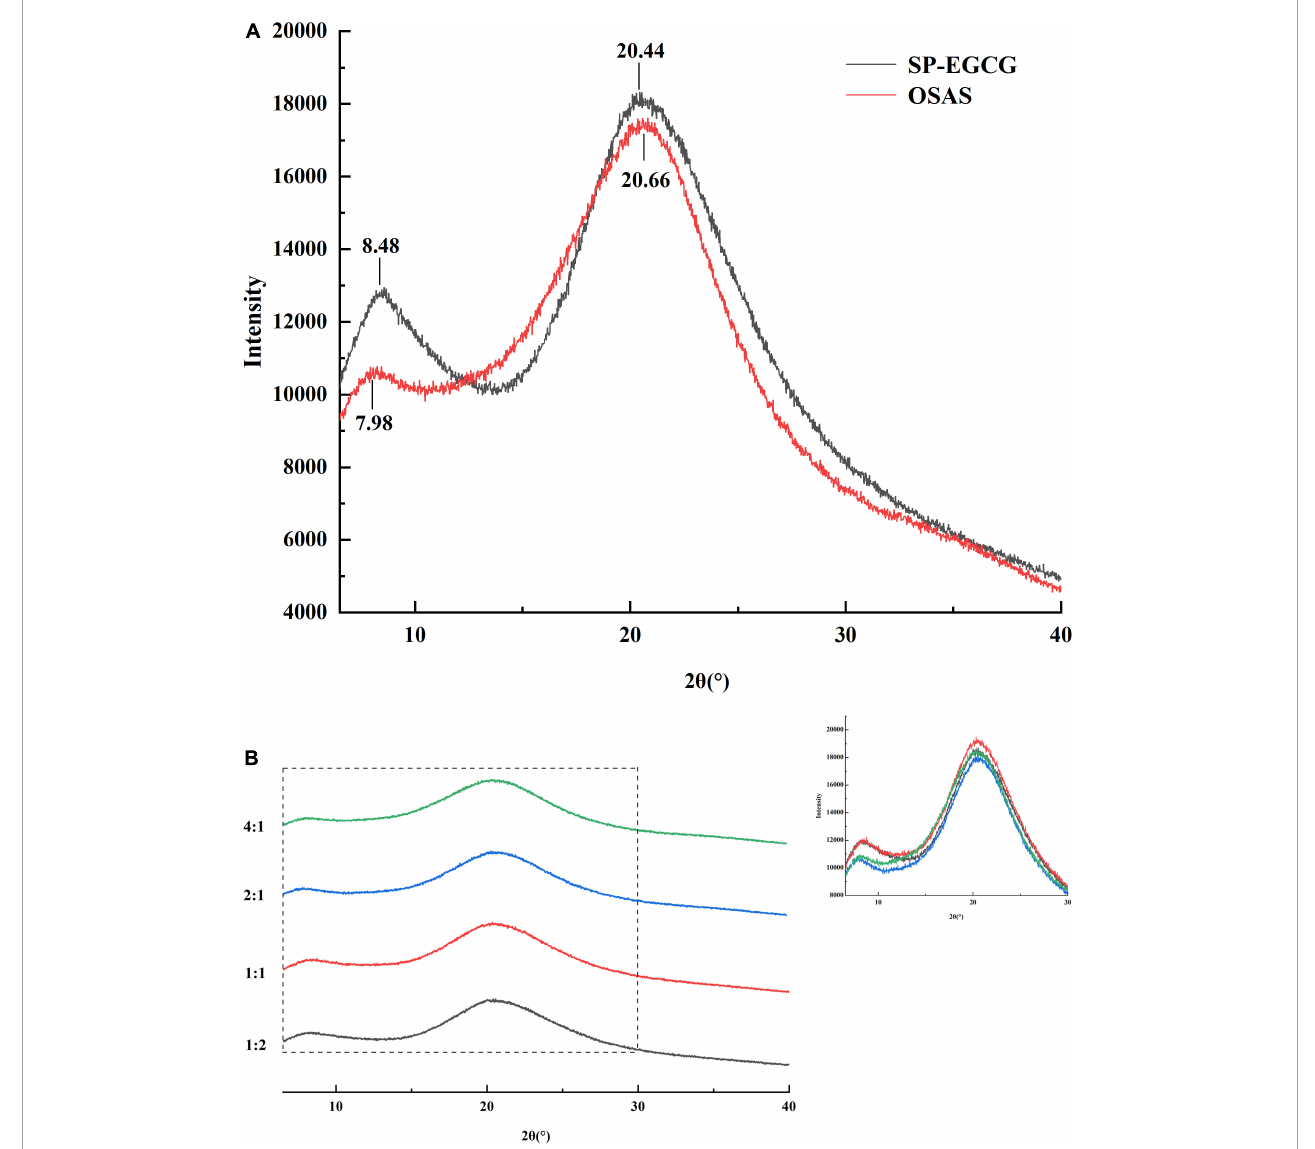
FIGURE4 XRD spectrum for OSAS, SP-EGCG complexes (A) and OSAS-SP-EGCG complexes (B)